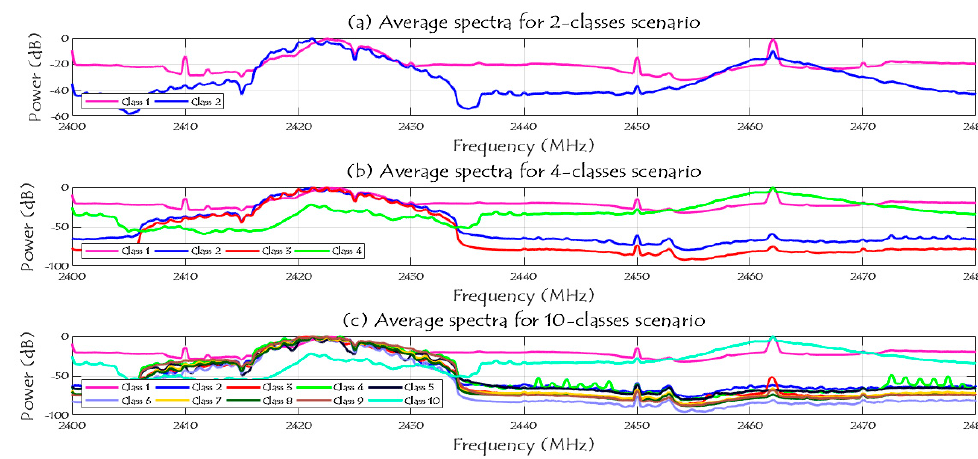
Figure 9. Average spectra of the RF activities for 2, 4, and 10 classes scenarios.